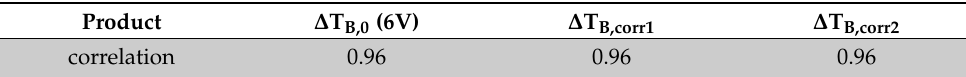
Figure 7. 2-dimensional logarithmic joint histogram of the SMAP V-pol specular surface TB bias ∆ T B,0 (SMAP V) and the scaled AMSR2 6.93 GHz V-pol specular TB bias test set (Table 1) within sea-ice zones 1–4. The bin size is 0.25 K. The value of the scaling factor is λ = 1.15. The dashed line indicates the 1:1 line (ideal case). The full line indicates the binned average between y -axis versus x -axis and x -axis versus y -axis. The Pearson correlation coefficient is 0.96. Table 4. Pearson correlation coefficients between the SMAP V-pol specular surface TB bias ∆ T B,0 (SMAP V) for the test set scenes (Table 1) within sea-ice zones 1–4. The AMSR2 6.93 GHz V-pol specular TB bias. The ∆ T B,corr1 and ∆ T B,corr2 are the values for the sea-ice corrections that were derived in Section